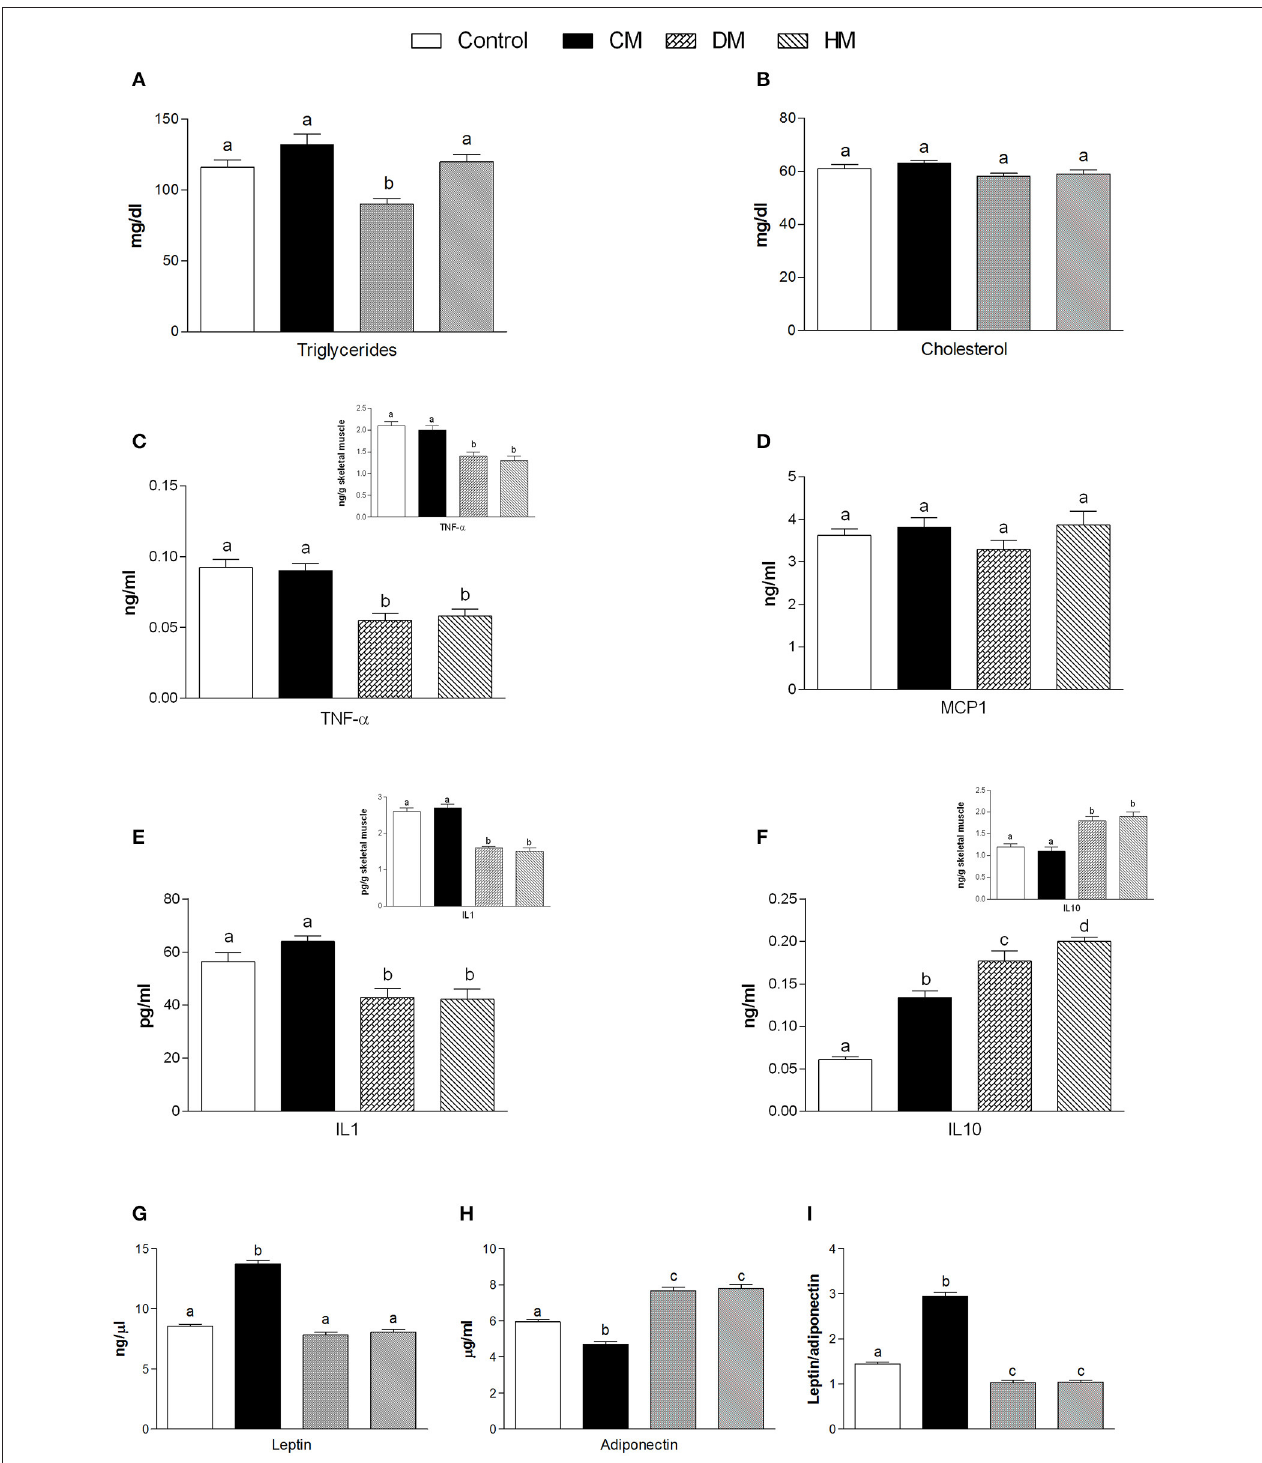
FIGURE 1 | Effects of oral administration of human, donkey and cow milk on serum levels of lipids, hormones and inflammatory parameters. The graphs show serum levels of triglycerides (A) , cholesterol (B) , TNF- α (C) , MCP1 (D) , Interleukin- 1 (IL 1 E ), interleukin-10 (IL 10 F ), leptin (G) , adiponectin (H) , and leptin/adiponectin ratio (I) . Insets indicate skeletal muscle levels of TNF- α (C) , IL 1 (E) , and IL 10 (F) . Data are presented as means ± SEM from n = 7 animals/group. Labeled means without a common letter differ ( P < 0.05).